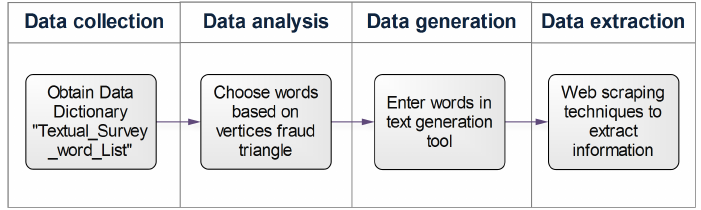
Figure 3. Flow diagram used for the generation of a synthetic